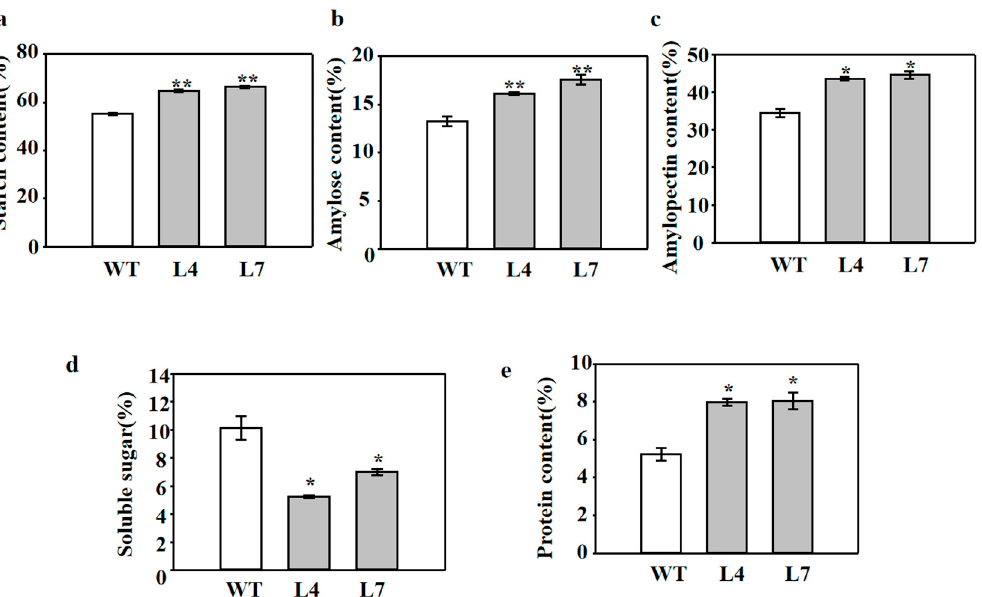
Figure 5. The overexpression of ZmCBM48-1 in rice altered the starch content. ( a ) Total starch content. ( b ) Amylose content. ( c ) Amylopectin content. ( d ) Soluble sugar content. ( e ) Protein content. Data are presented as means ± SD from three replicates. ** and * represent significant differences between WT and transgenic plants at p < 0.01 and p < 0.05, respectively.